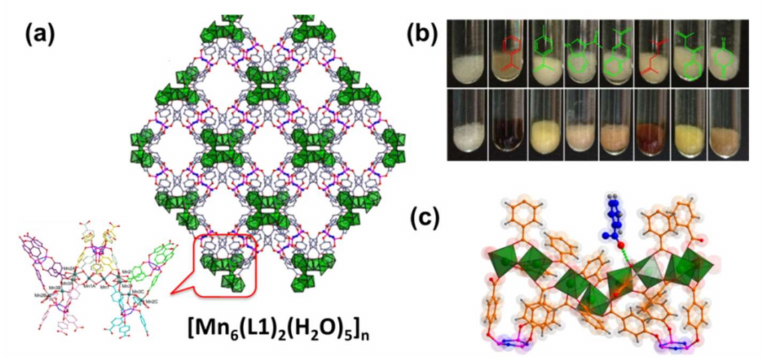
Figure 19. ( a ) Structure of [Mn 6 (L 1 ) 2 (H 2 O) 5 ] n . ( b ) Photographs of different solvent-loaded [Mn 6 (L 1 ) 2 (H 2 O) 5 ] n . ( c ) Perspective view of the hydrogen-bonding interaction between the ace- tophenone molecule (blue color) and host framework. Adapted from